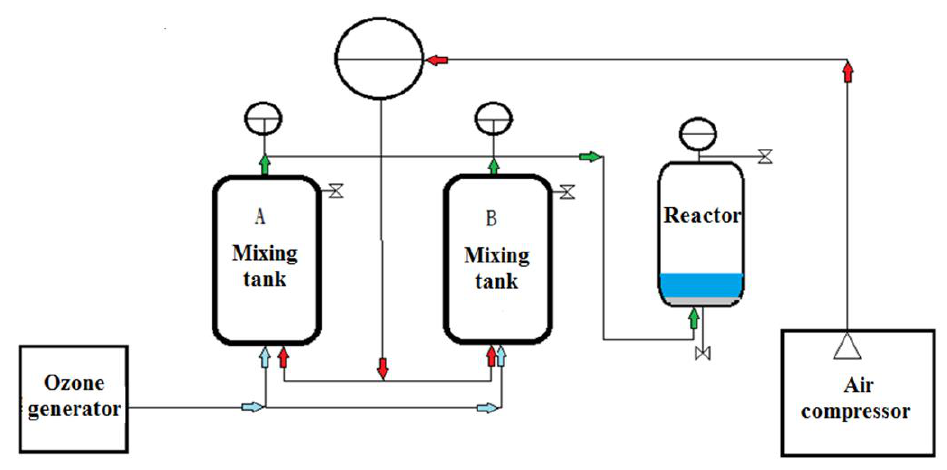
Figure 1. Scheme of pressure-assisted oxidation system